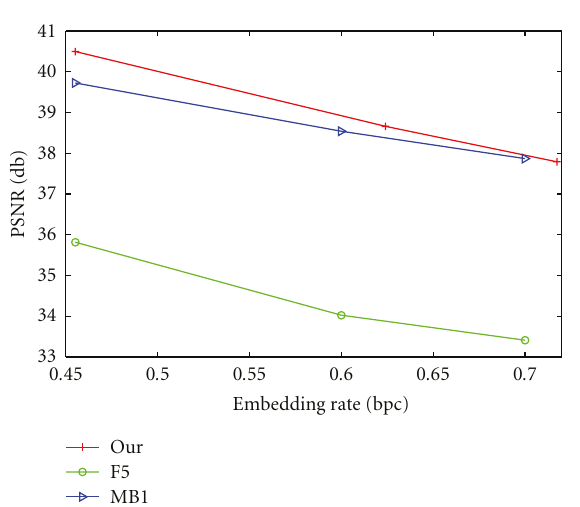
Figure 6: Distribution of the (2,1)th AC